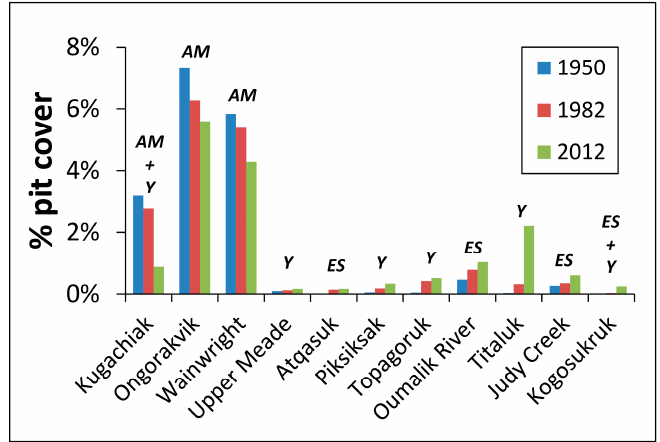
Figure 3. Percent of residual upland area covered by flooded thaw pits for the three epochs at the study areas, North Slope, Alaska. Study areas are ordered from west to east; geomorphic unit(s) at each site are indicated by abbreviations (AM = alluvio-marine, Y = yedoma, ES = eolian sand). Changes in thaw pit extent were variable at the Beaufort sites dominated by eolian sand. Thaw pits occupied a very low percentage of residual landscapes at most sites in the early period (0–0.5% of deposit), particularly at Atqasuk where virtually no pits were present. Pit extent increased markedly by the late period at all four sites with eolian sand on a percent basis; however, pits still occupied a very low proportion of residual deposits (<1%). Rates of thaw-pit development were highest from c. 1950 to c. 1982 at Atqasuk and Ouamalik River, but higher after c. 1982 Judy Creek, the easternmost site.